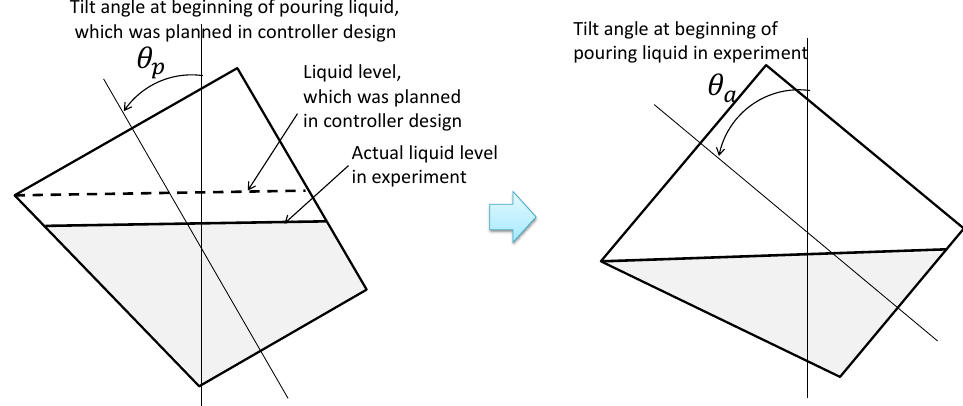
Figure 11. Illustration of the disturbance applied in the experiments, which was caused by a difference between the tilt angles at the beginning of pouring the liquid in the experiments and the controller